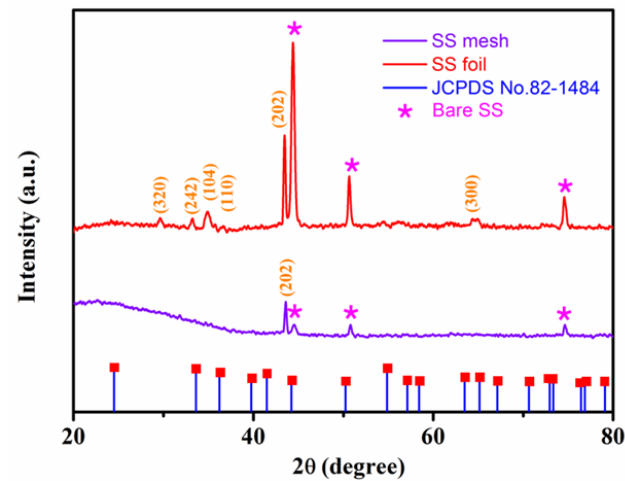
Figure 6. X-ray diffraction (XRD) patterns (reference: JCPDS card No. 82-1484) of the MONs grown on stainless steel mesh and foil in 1100 ° C for 1 h.